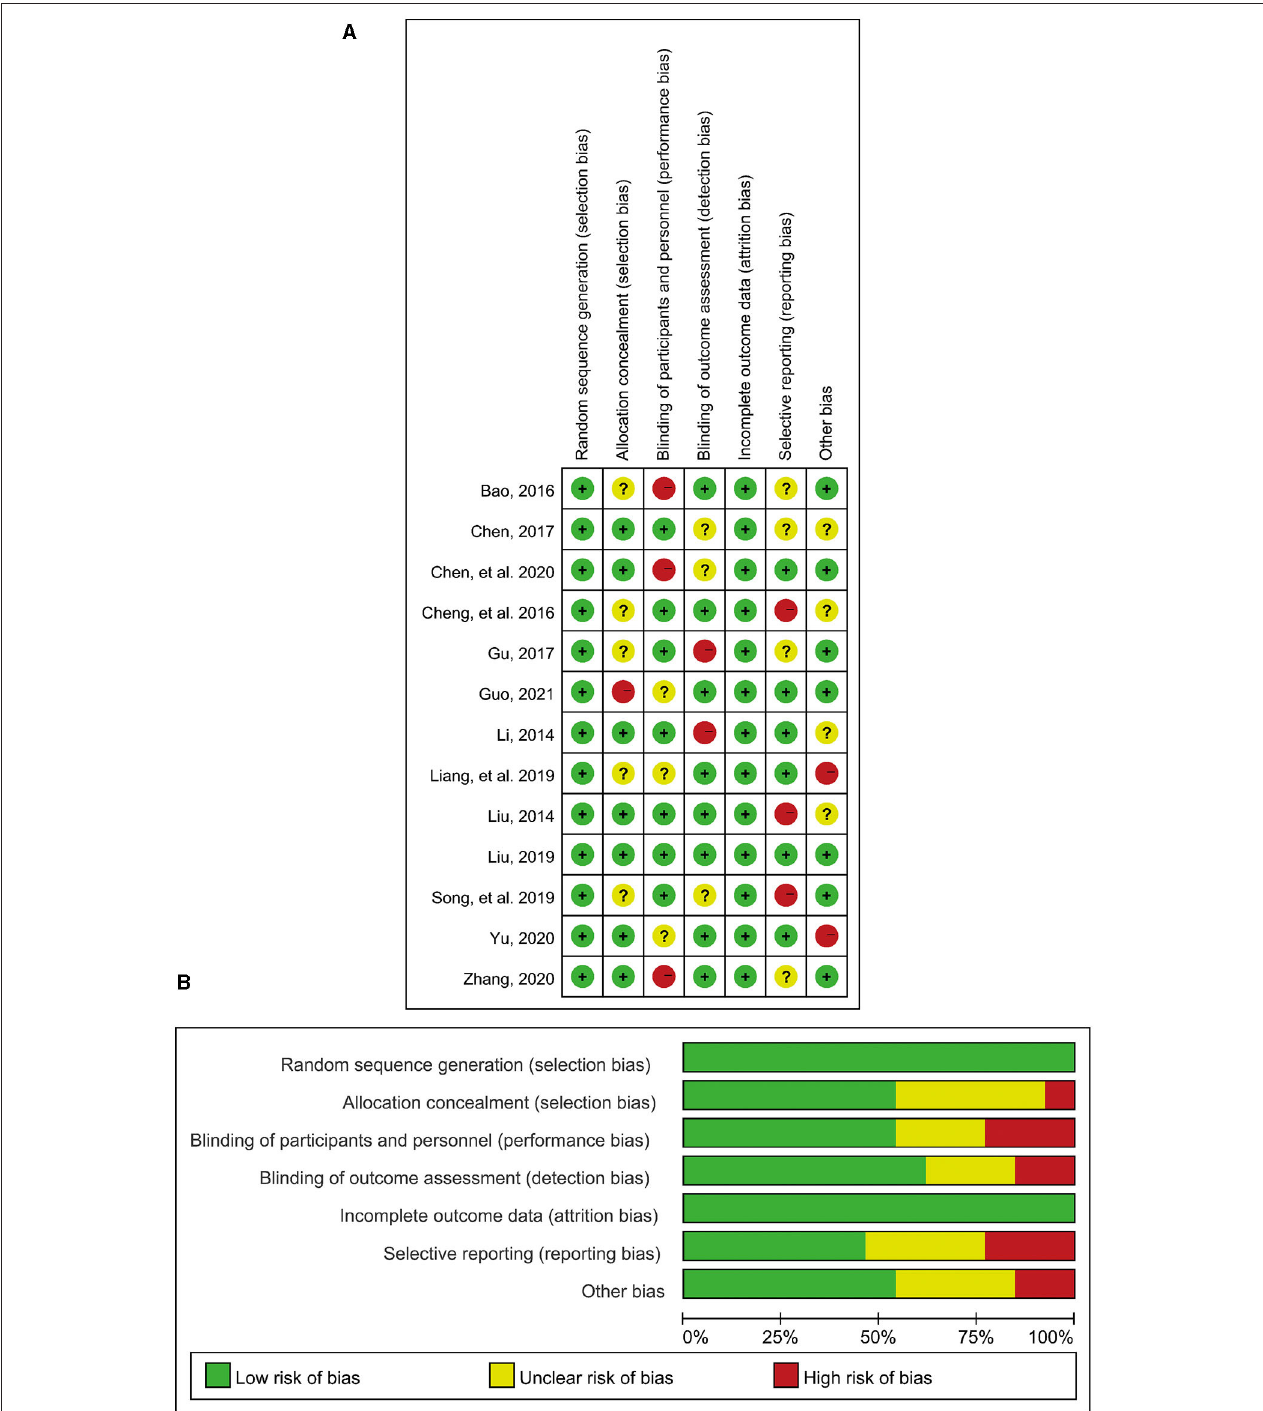
FIGURE 2 | Literature quality assessment. (A) Risk of bias summary: Review judgments of authors about each risk of bias item for each included study; (B) Risk of bias graph: Review judgments of authors about each risk of bias item presented as percentages across all included studies.